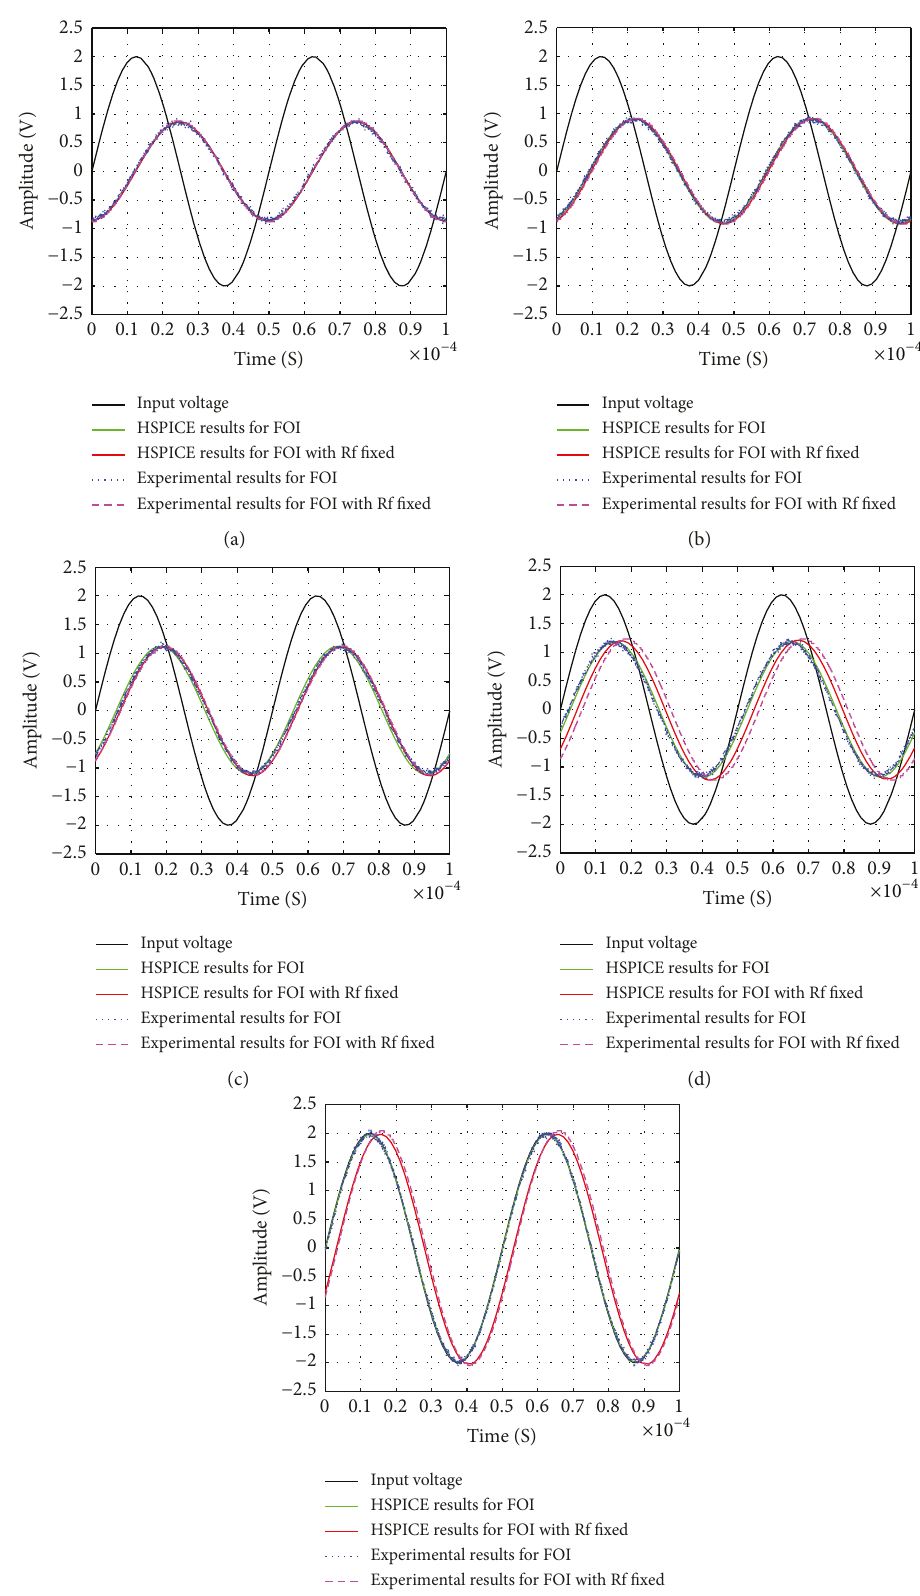
Figure 2: Transient responses of IOI, FOI, and FOI with 𝑅 𝑓 fixed when (a) 𝛼 = 0.99, (b) 𝛼 = 0.75, (c) 𝛼 = 0.5, (d) 𝛼 = 0.25, and (e) 𝛼 = 1m, all operating to f = 20